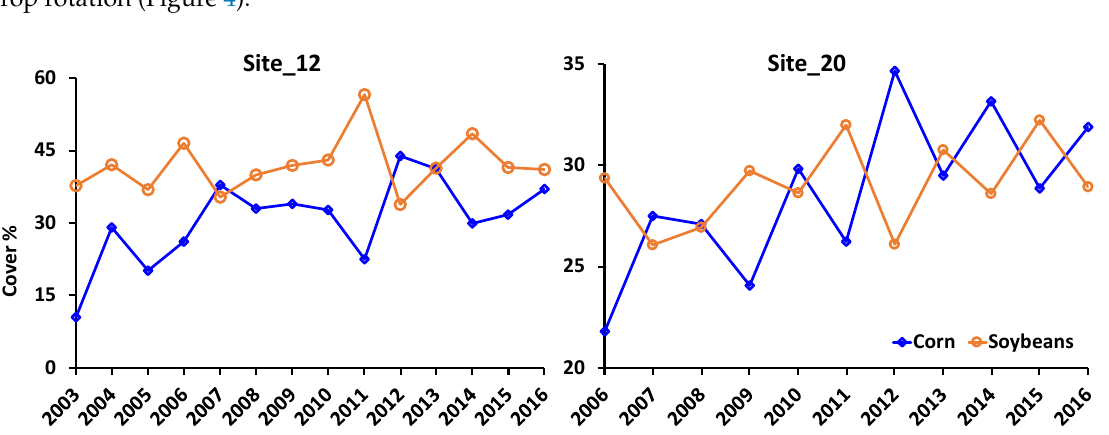
Figure 3. Temporal average proportion of crops (corn plus soybeans), grasslands / pastures, and wetlands for ( a ) 13 AMSR-pixels study sites transect in ND (2003–2016) and ( b ) 10 sites in SD (2006–2016). Note the general spatial trend of cropland versus grassland / pasture in both transects. Bars indicate two standard errors ( ± 2SE) of interannual variation. Table 1. The temporal average proportion of cover type for the 13 AMSR-pixels study sites transect in ND (2003–2016) and 10 sites in SD (2006–2016). Note the general spatial trend of crop versus grassland/pasture covers in both transects.